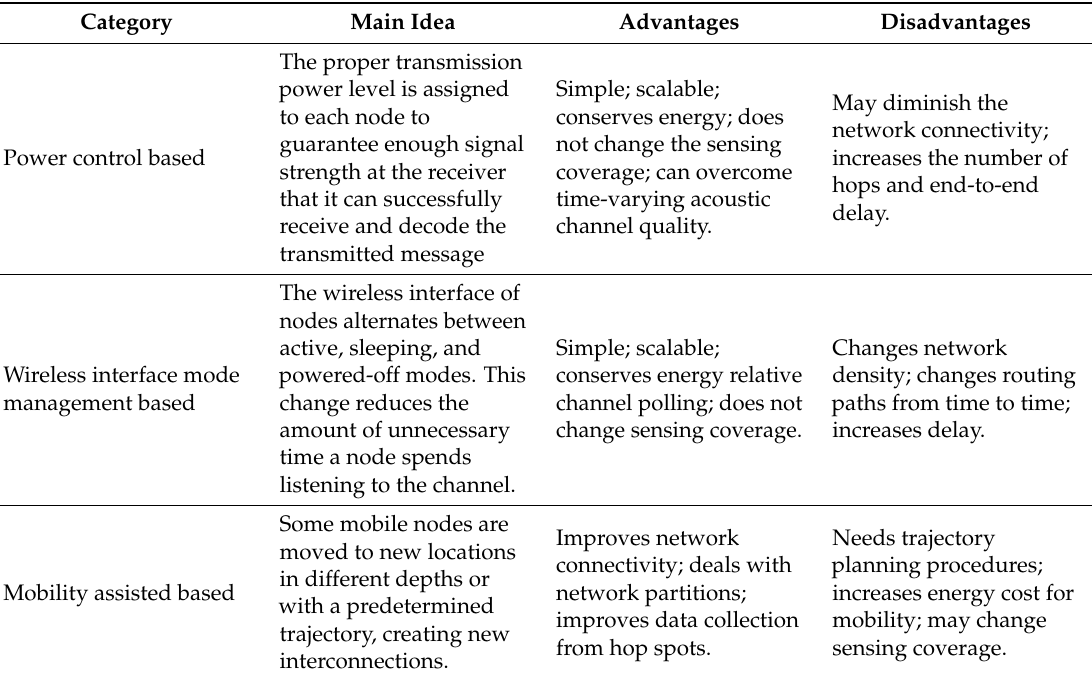
Table 2. Classification of Topology Control Algorithms for underwater wireless senor networks